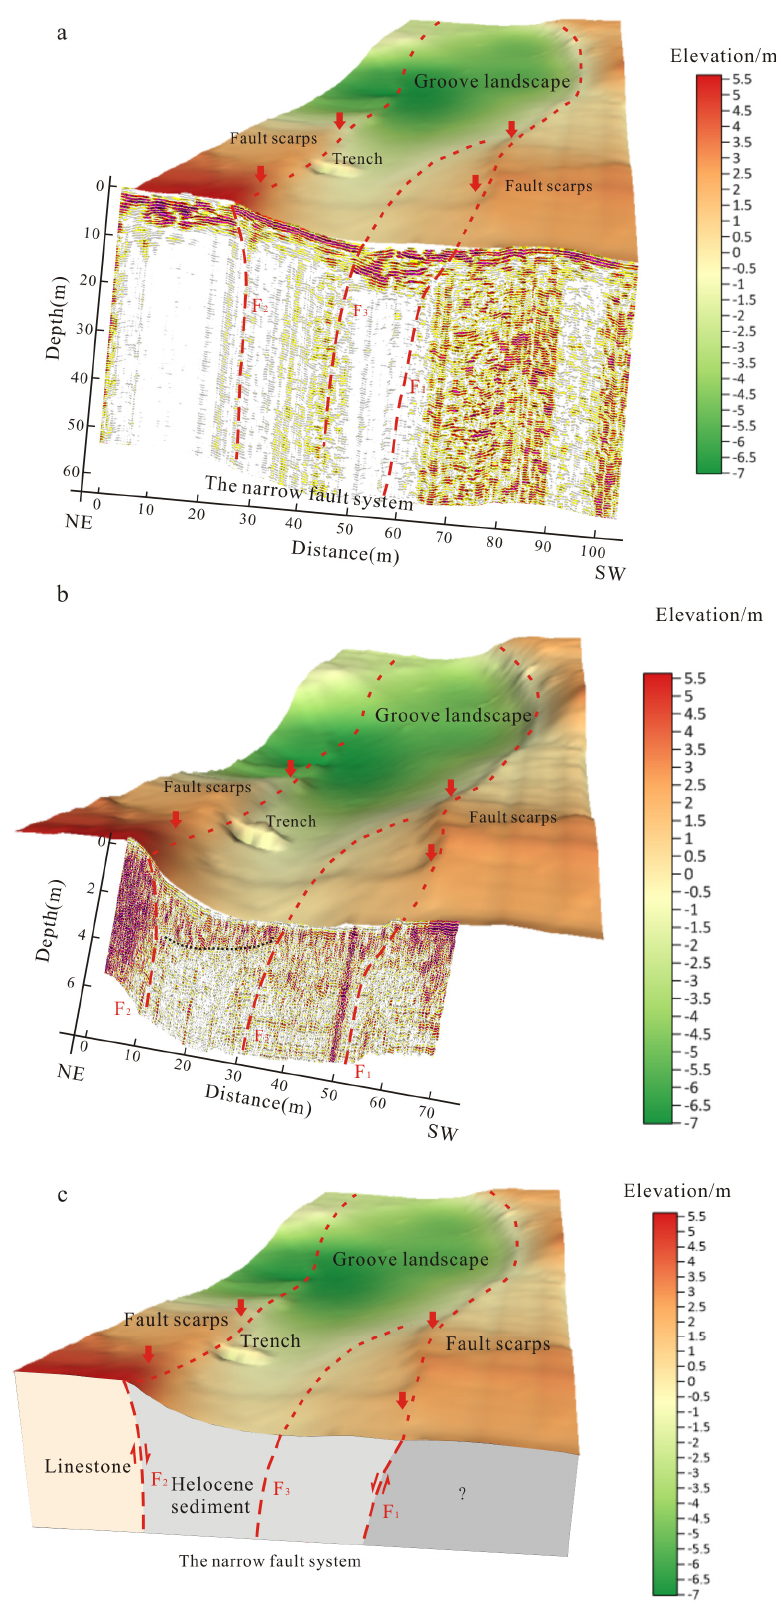
Figure 11. 3D sur fi cial and subsurface model. ( a ) Integration of the 3D sur fi cial model and 25 MHz Figure 11. 3D surficial and subsurface model. ( a ) Integration of the 3D surficial model and 25 MHz GPR pro fi le. ( b ) Integration of the 3D sur fi cial model and 500 MHz GPR pro fi le. ( c ) 3D sur fi cial and GPR profile. ( b ) Integration of the 3D surficial model and 500 MHz GPR profile. ( c ) 3D surficial and subsurface model. subsurface